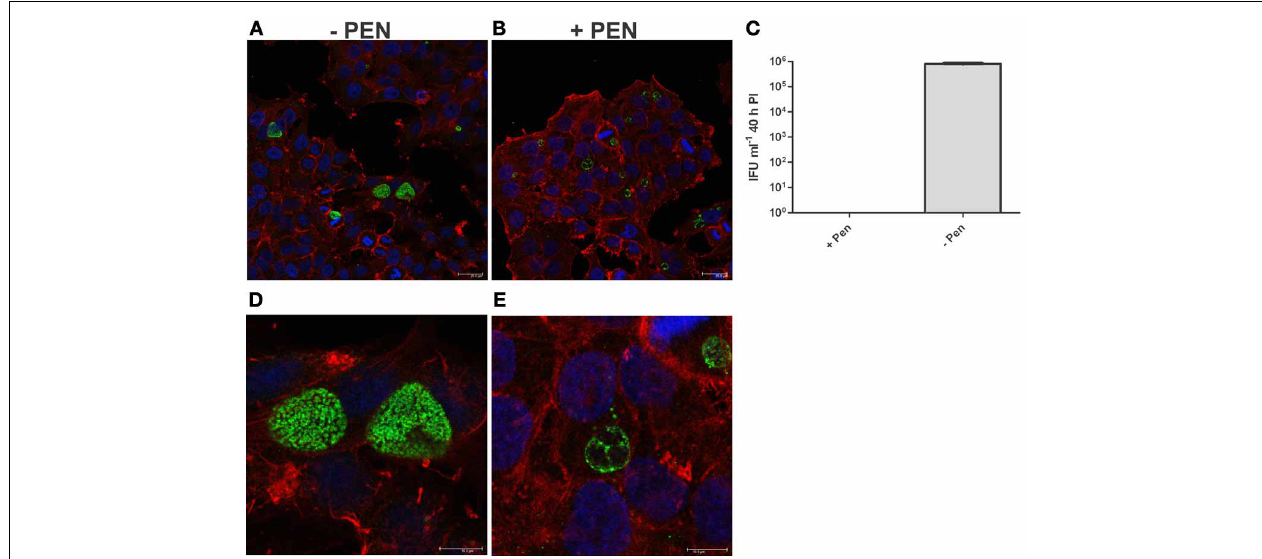
FIGURE 6 | Penicillin persistence cultures prior to commencement of reversion are not viable and are morphologically consistent with persistence. Cultures were treated with penicillin 100U ml − 1 at 4h PI. (A) Confocal microscopy image of cultures at 40h PI in the presence of penicillin ( + PEN) (B) Confocal microscopy image of cultures at 40h PI in the absence of penicillin ( − PEN). The scale bar indicates 25 μ m.